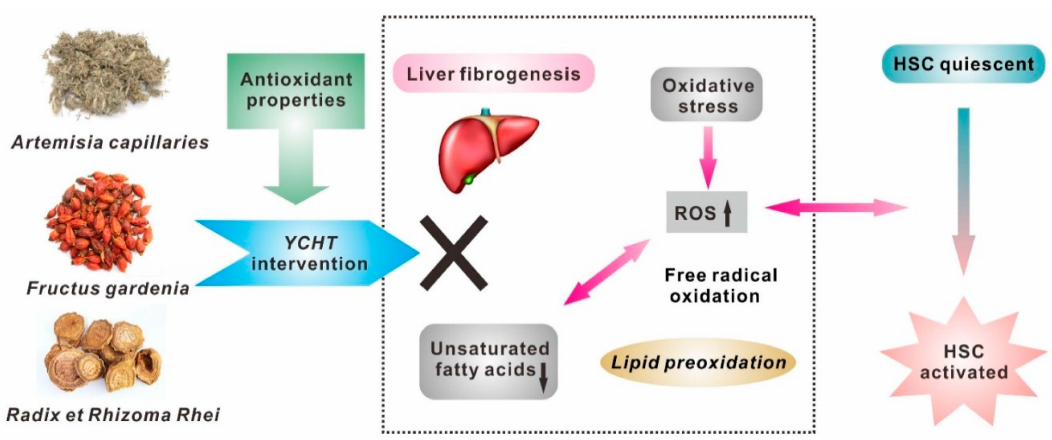
Figure 6. Proposed mechanistic pathways for the DMN-induced liver fibrosis and anti-fibrotic effects of YCHT. Upward arrowhead indicates up-regulation and downward arrowhead indicates down-regulation. HSC, hepatic stellate cell; ROS, reactive oxygen species; YCHT,